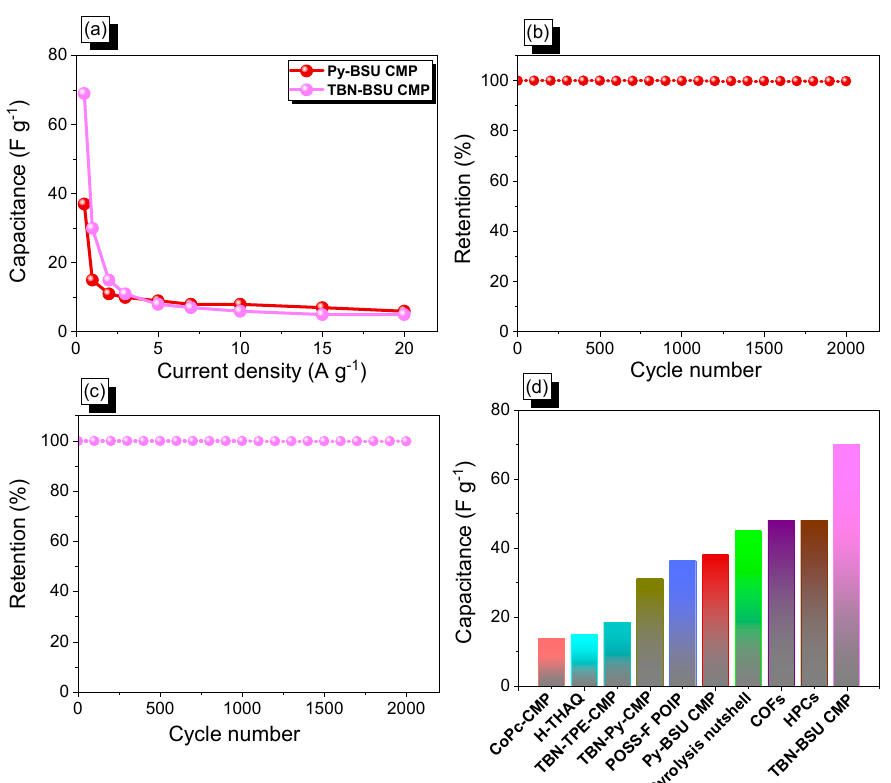
Figure 6. Capacitance ( a ) and stability ( b , c ) and the performance of Py-BSU CMP and TBN-BSU CMP precursors compared with other POPs in energy storage ( d ).